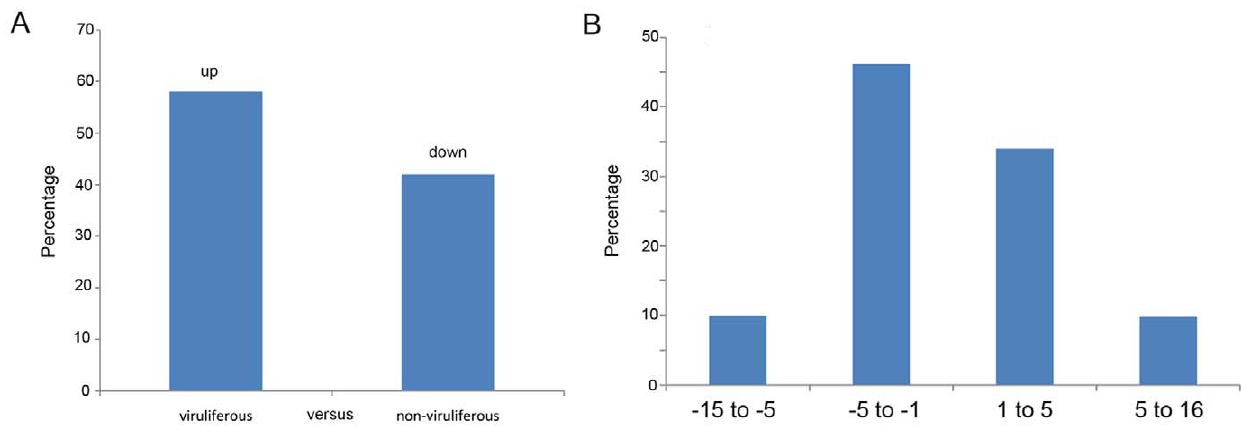
Figure 8. Summary of differentially expressed genes between the two libraries. (A) Summary of the percent of differentially expressed genes in the Southern rice black-streaked virus infected Sogatella furcifera . (B) Fold change distribution of differentially expressed genes.